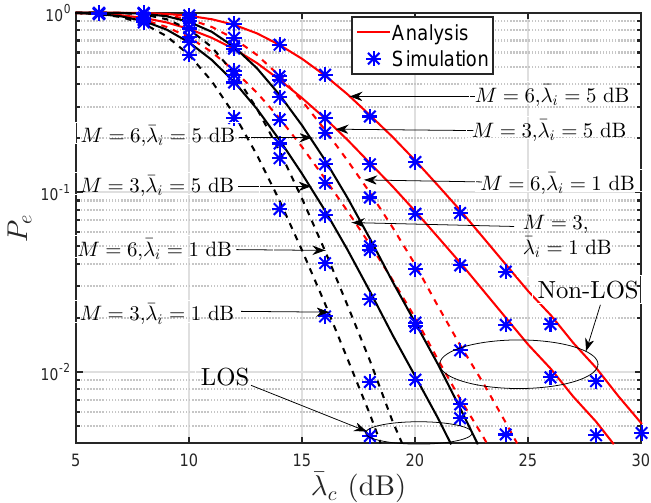
Figure 2. Probability of receiving erroneous packets versus ¯ λ c